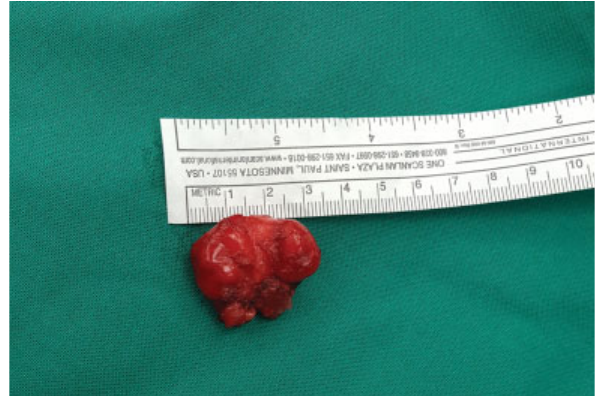
Fig. 4 Extirpated tumor of 3 (cid:3) 2cm in